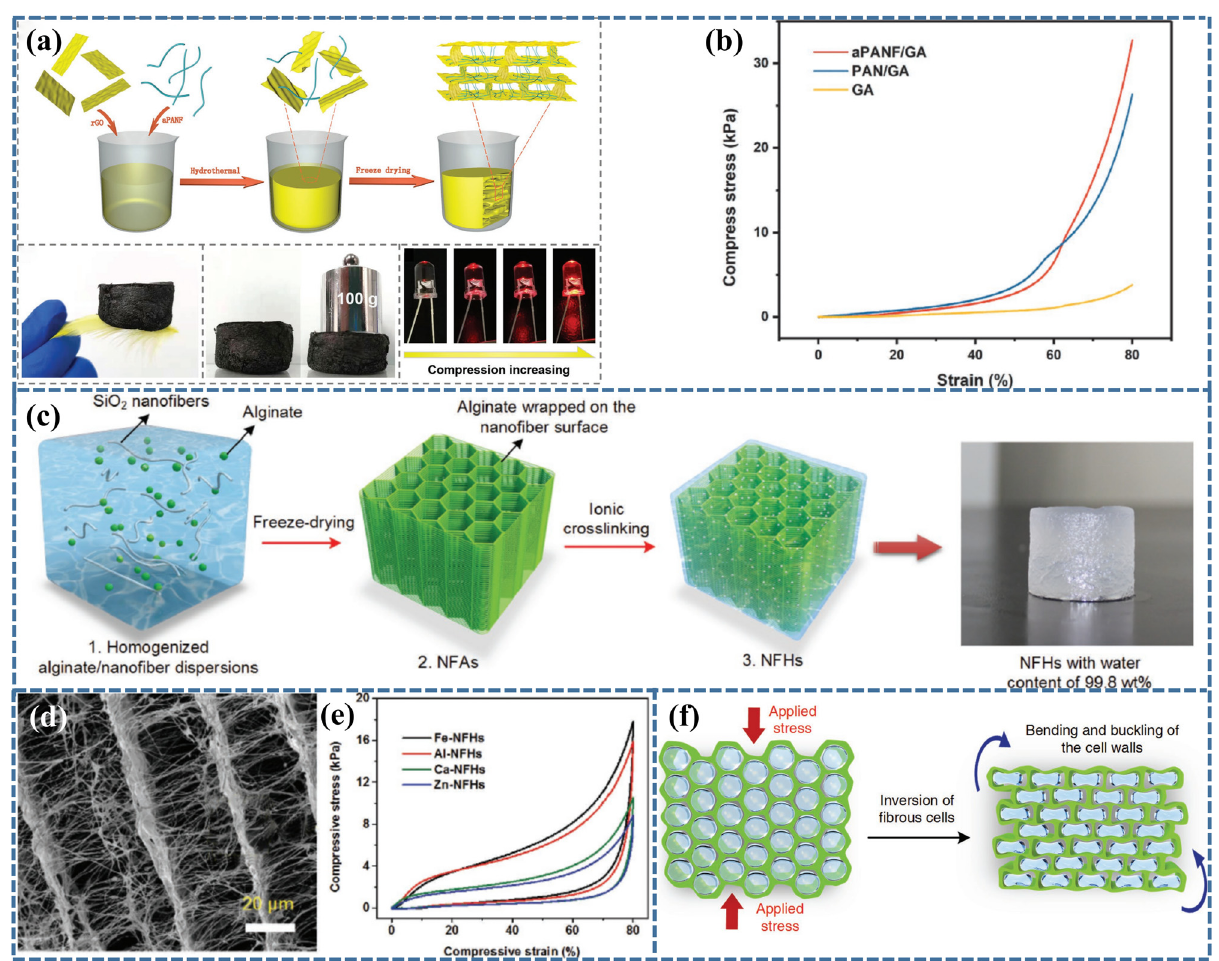
Figure 4: ( a ) The fabrication process, the mechanical property, and the conductivity of aPANF/GA. ( b ) Compressive σ – ε curve of GA, PAN/GA, and aPANF/GA 0.5 – 1 ( ε form 0 – 80% ) [ 44 ] ( Copyright 2020, Wiley ) . ( c ) Schematic for creating high water containing and superelastic nano fi brous hydrogels ( NFHs ) with ordered cellular structures using sustainable alginate and electrospun nano fi bers. ( d ) SEM image of NFHs demonstrating the hierarchical nano fi brous cellular architecture. ( e ) Compressive σ versus ε curves for NFHs cross - linked by various metallic cations. ( f ) Schematic demonstration of the inversion of the nano fi brous cell walls under compression [ 46 ] ( Copyright 2017, Wiley )